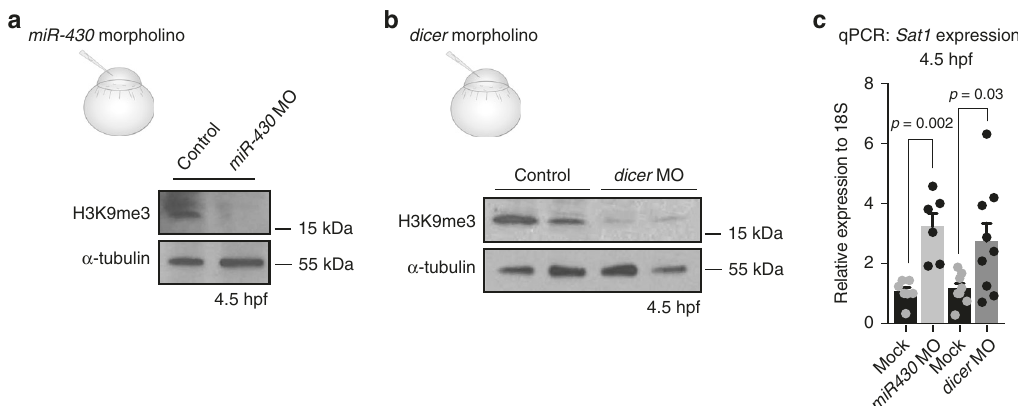
Fig. 4 miR-430 is required for heterochromatin establishment. a Western blot for H3K9me3 (top) and α -tubulin (bottom) in embryos that were either mock injected or injected with 2 ng of miR-430 morpholino at the one-cell stage. Protein was collected for analysis at 4.5 h post fertilization (hpf). b Western blot for H3K9me3 (top) and α -tubulin (bottom) using protein extracted from embryos that were either injected with 2 ng of control morpholino or injected with dicer morpholino at the one-cell stage. Protein was collected for analysis at 4.5 hpf. c Satellite-1 (Sat1) pericentromeric transcript levels in 4.5 hpf embryos that were either injected with control morpholino or injected with miR-430 or dicer morpholino at the one-cell stage. P values were calculated using the Student ’ s t test; error bars indicate SEM. Source data for panels a and b is provided as source data fi